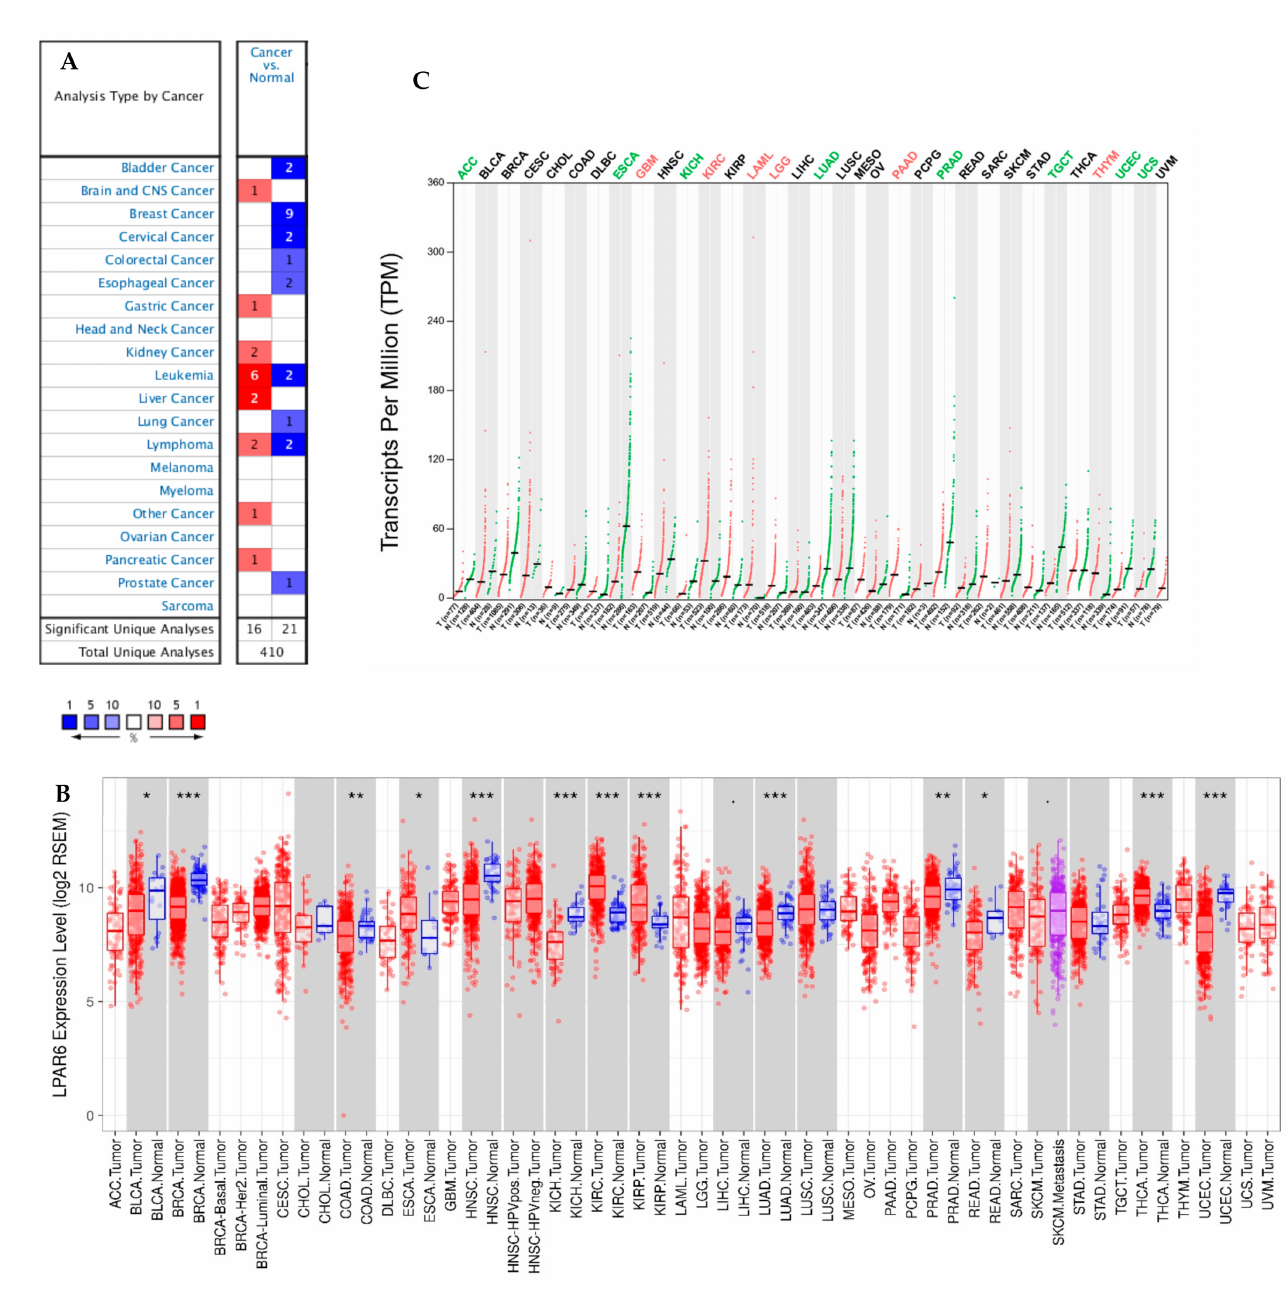
Figure 1. LPAR6 mRNA expression levels in different types of human cancers in different databases. ( A ) Increased or decreased LPAR6 in data sets of different cancers compared with normal tissues. Cell color is determined by the best gene rank percentile for the analyses within the cell. ( B ) Human LPAR6 expression levels in different tumor types from TCGA database. One category of cancer is in one box, and paired tissue (tumor and adjacent) are in grey boxes. p < 0.1, * p < 0.05, ** p < 0.01, *** p < 0.001. ( C ) LPAR6 expression profile across all tumor samples and paired normal tissues (Dot plot) via GEPIA. Each dots represent the expression of